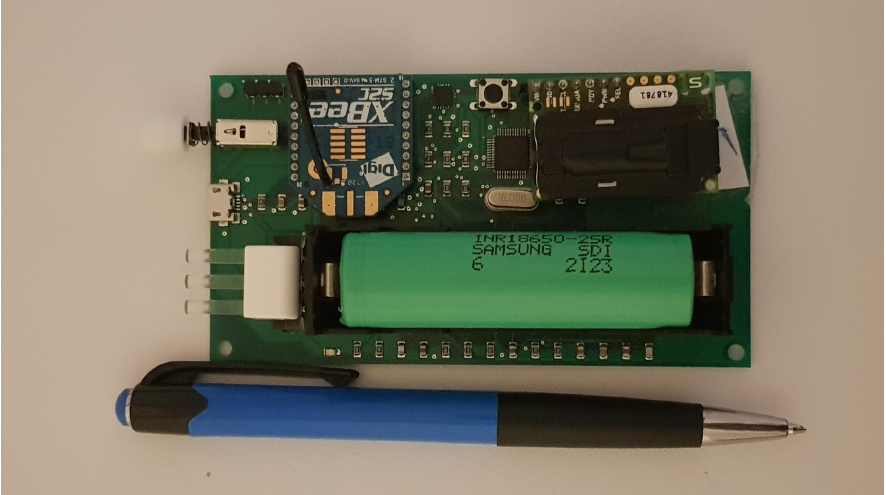
Figure 1. Sensor